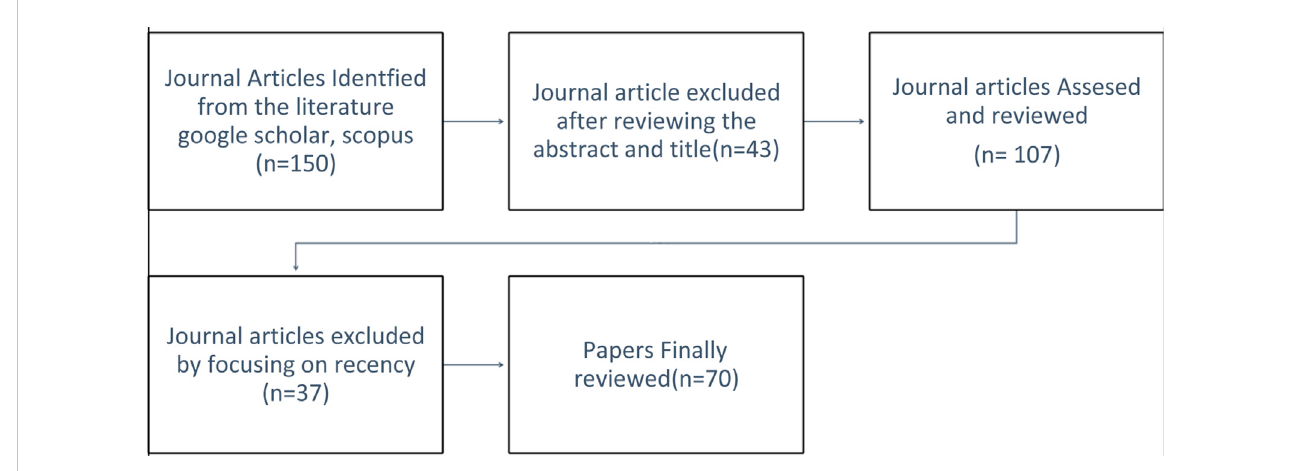
FIGURE 3 A fl owchart depicting the process of conducting a literature review.